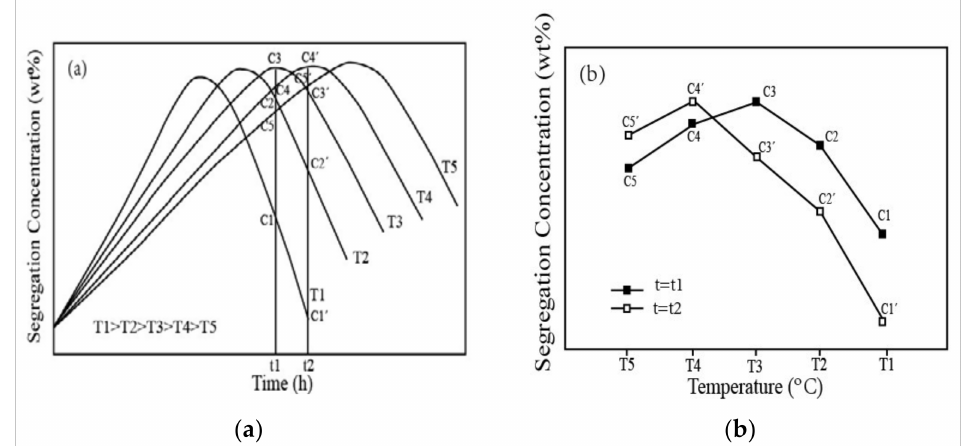
Figure 19. ( a ) A schematic diagram showing the variation of grain boundary concentration of solute with elastic deformation time at temperatures T 1 , T 2 , T 3 , T 4 , and T 5 ( T 1 > T 2 > T 3 > T 4 > T 5 ). The vertical lines are for the EDTs of t 1 and t 2 , respectively. ( b ) Grain boundary concentrations of solute at temperatures T 1 , T 2 , T 3 , T 4 , and T 5 for the EDTs of t 1 and t 2 , respectively. Reprinted with permission from ref. [28]. Copyright 2012 Acta Physica